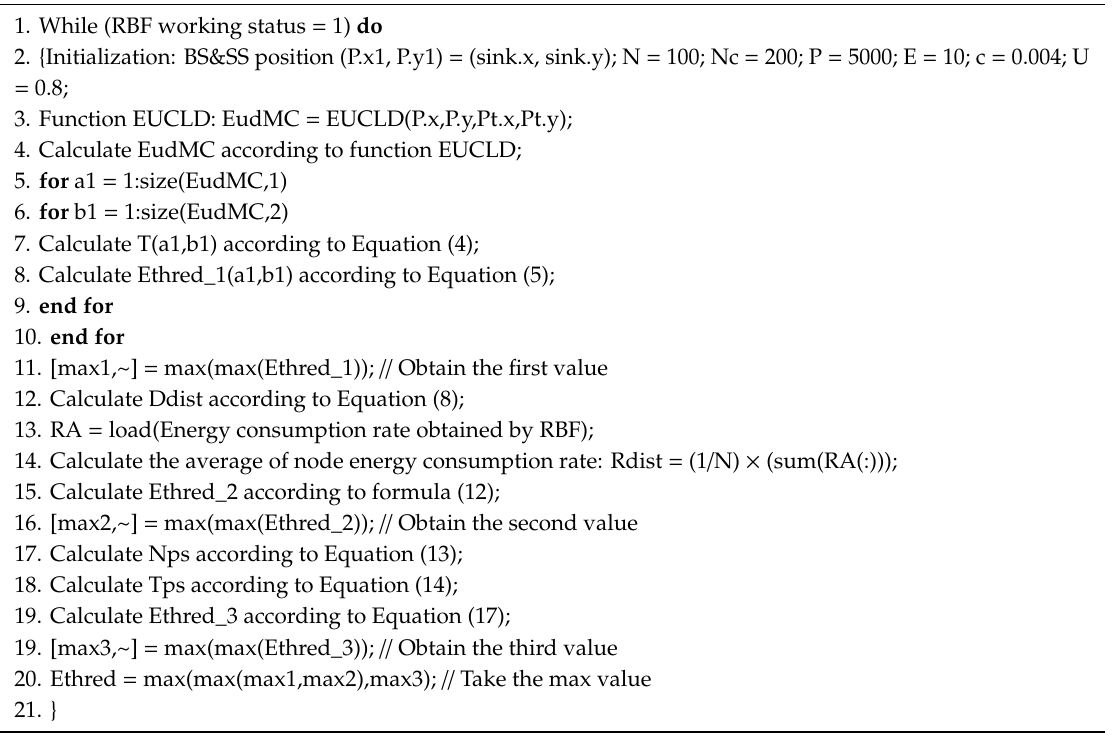
Algorithm 1 . Algorithm for selecting the charging threshold E